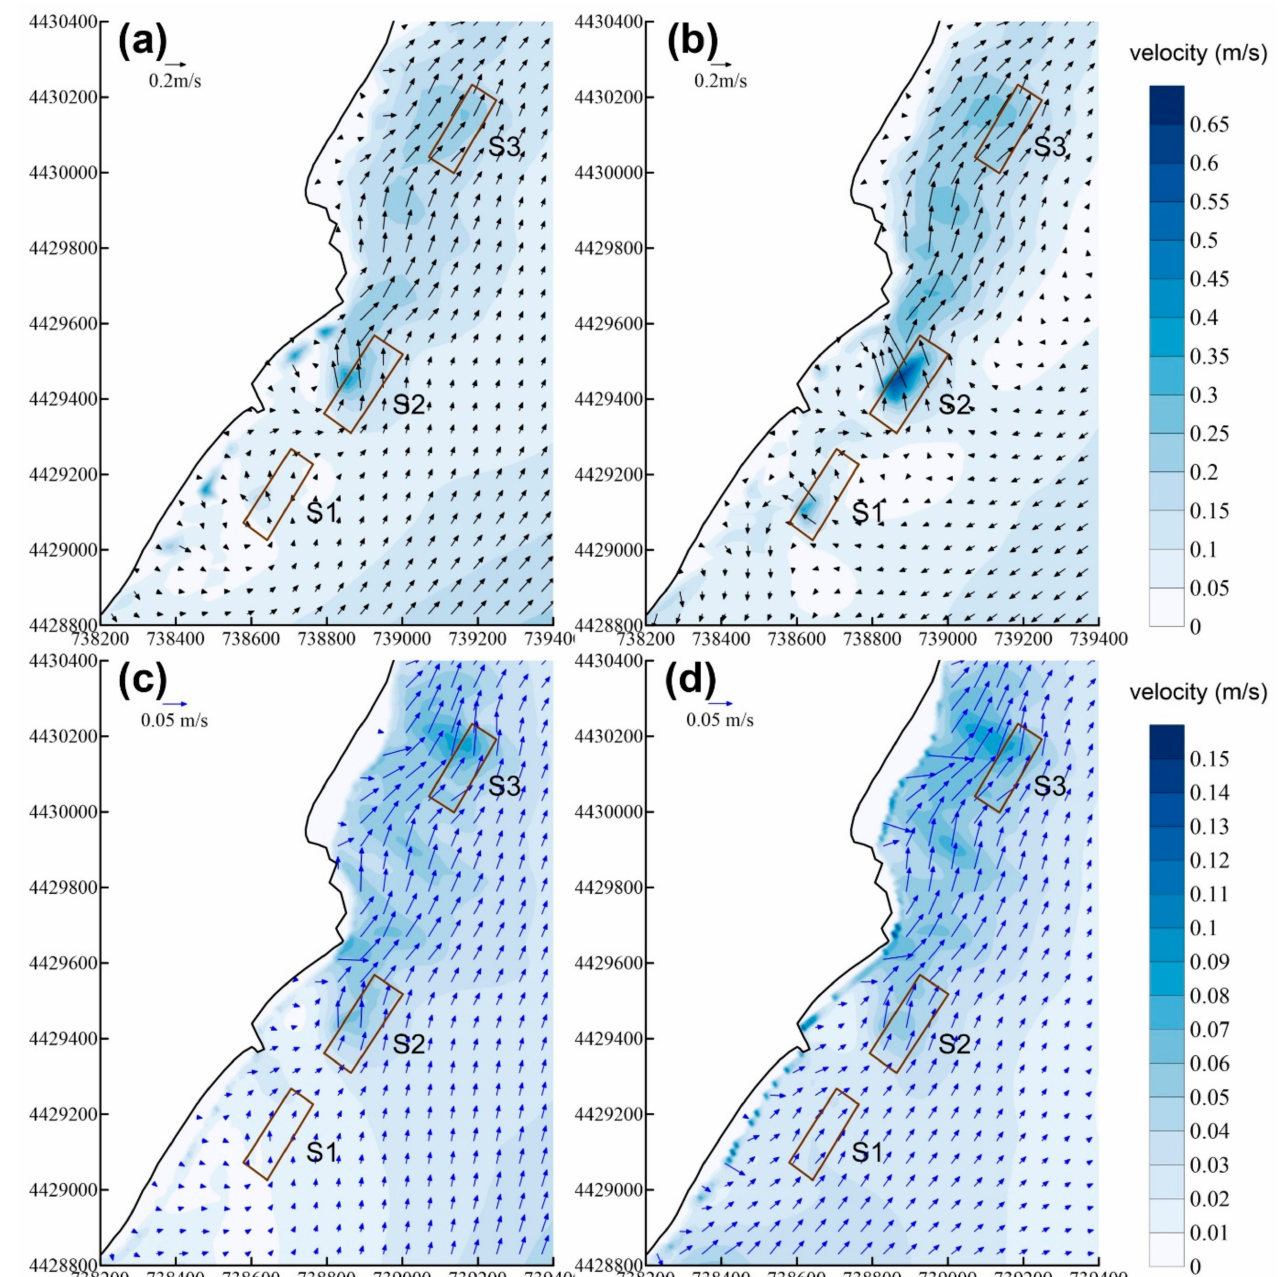
Figure 12. ( a ) Instantaneous current field for the tide-wave simulation at the strong wave moment during the selected tidal cycle period on 27 September 2017; ( b ) instantaneous current field for the wave-only simulation at the same moment as ( a ); ( c ) residual current field for the tide-wave simulation during the selected tidal cycle period on 27 September 2017; ( d ) residual current field for the wave-only simulation during the same period as ( c